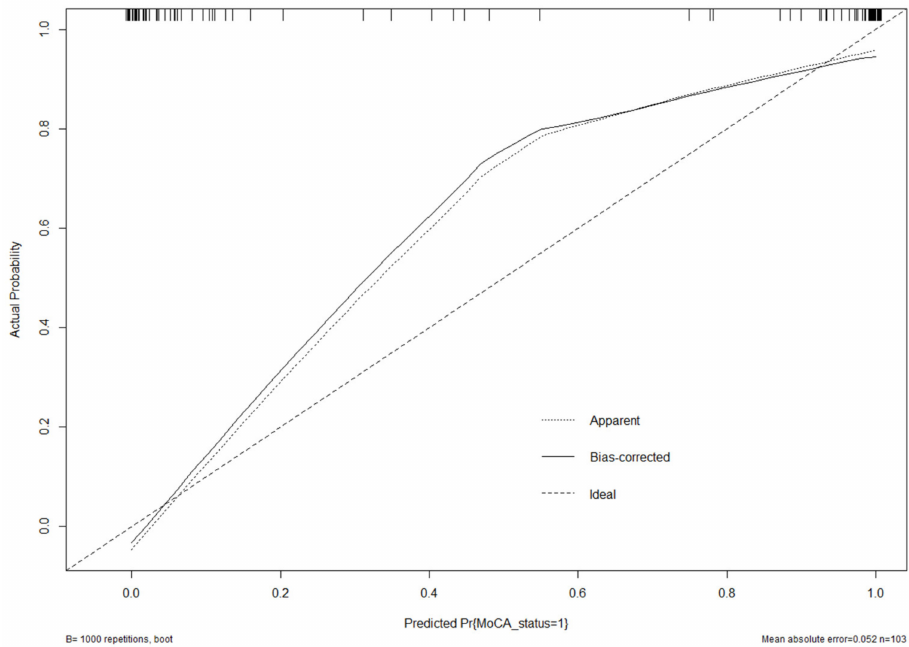
Figure 6. Calibration curve of the model. The calibration of the model in line with the agreement between predicted and observed outcomes of improvement of MoCA score.